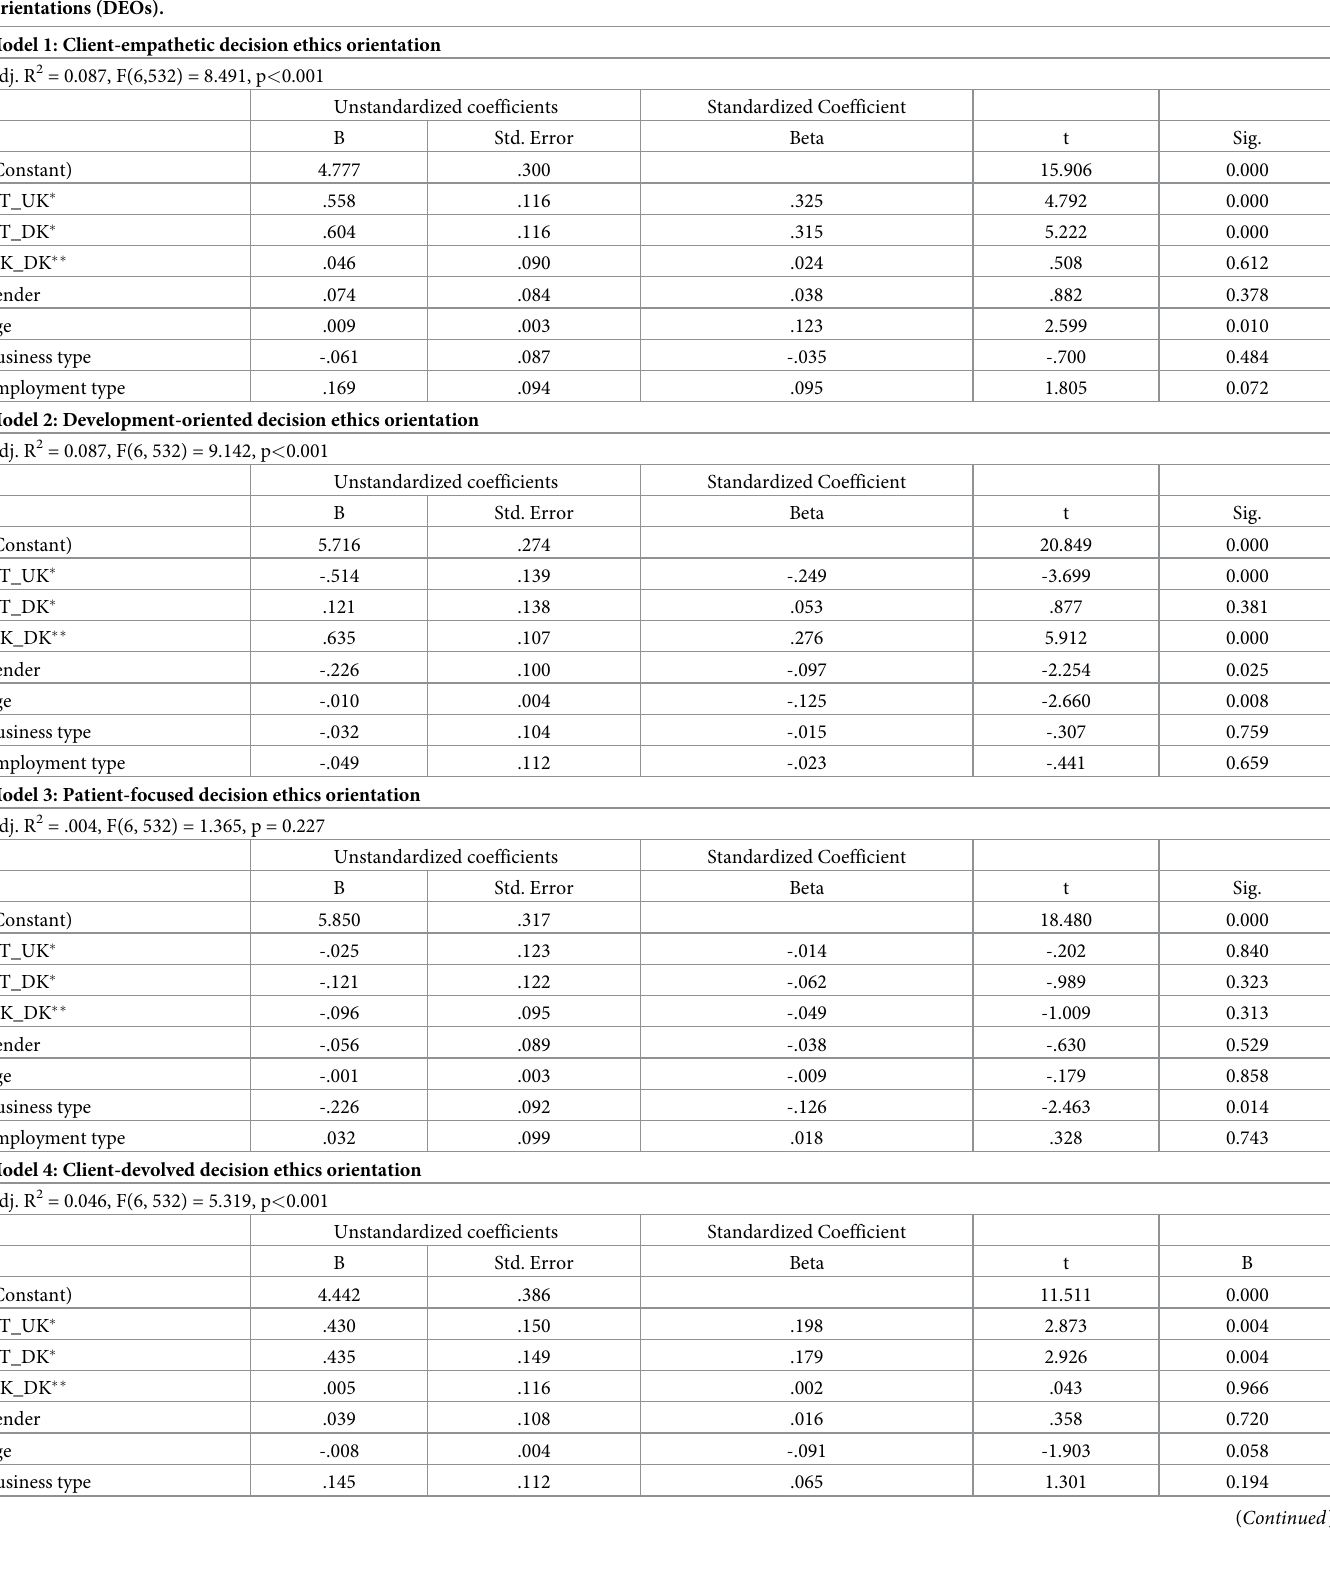
Table 6. Multivariate regression analyses of predictors (including socio-demographic (with age), practice-specific factors, and country) of the four Decision Ethics Orientations (DEOs). Model 1: Client-empathetic decision ethics orientation